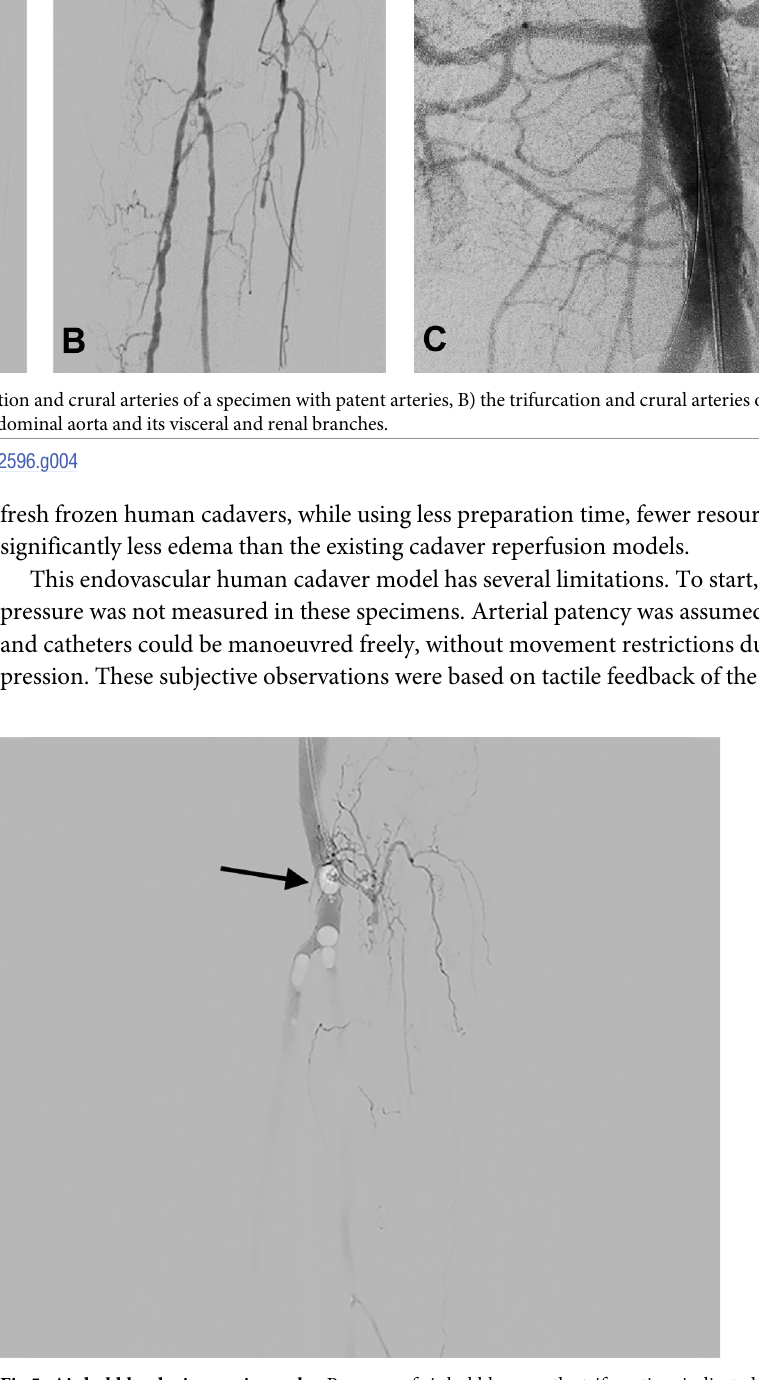
Fig 5. Air bubbles during angiography. Presence of air bubbles near the trifurcation, indicated with an arrow.